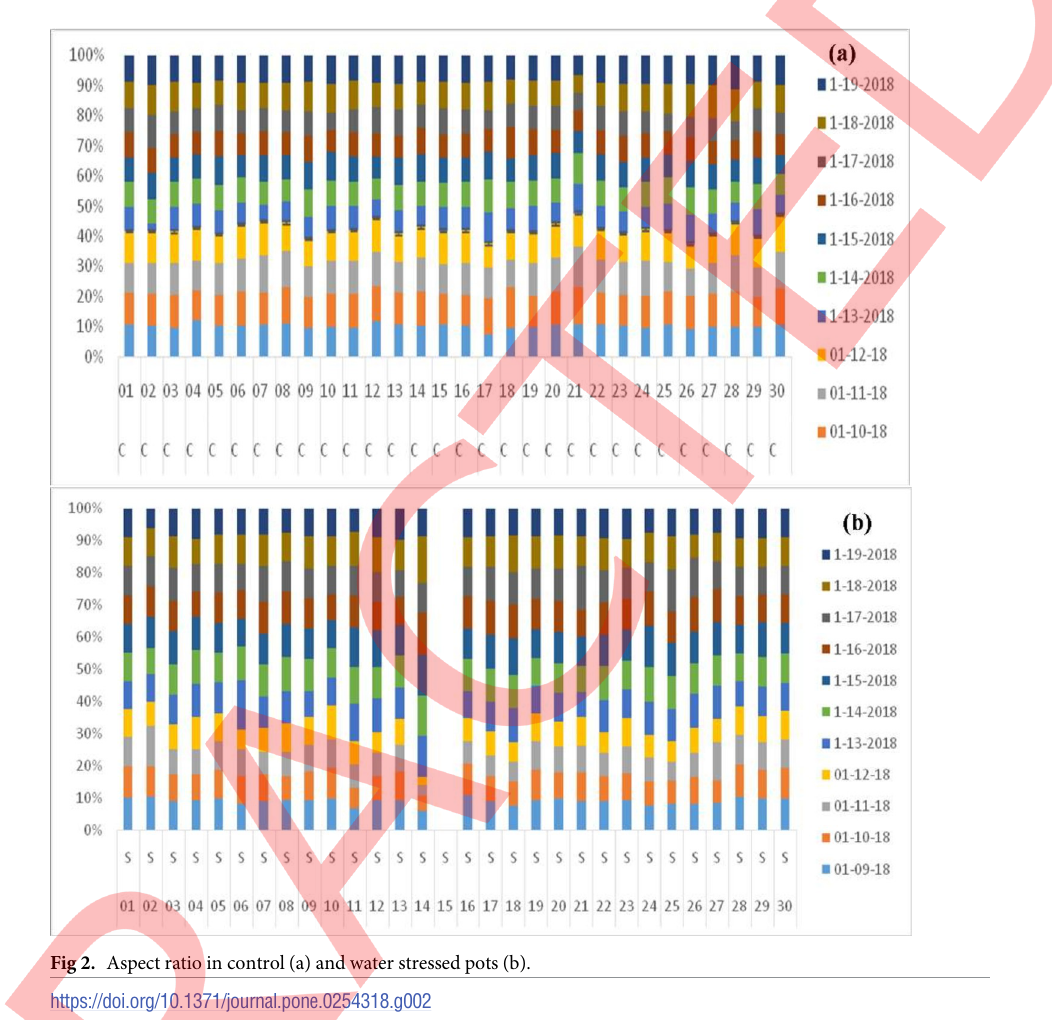
Fig 2. Aspect ratio in control (a) and water stressed pots